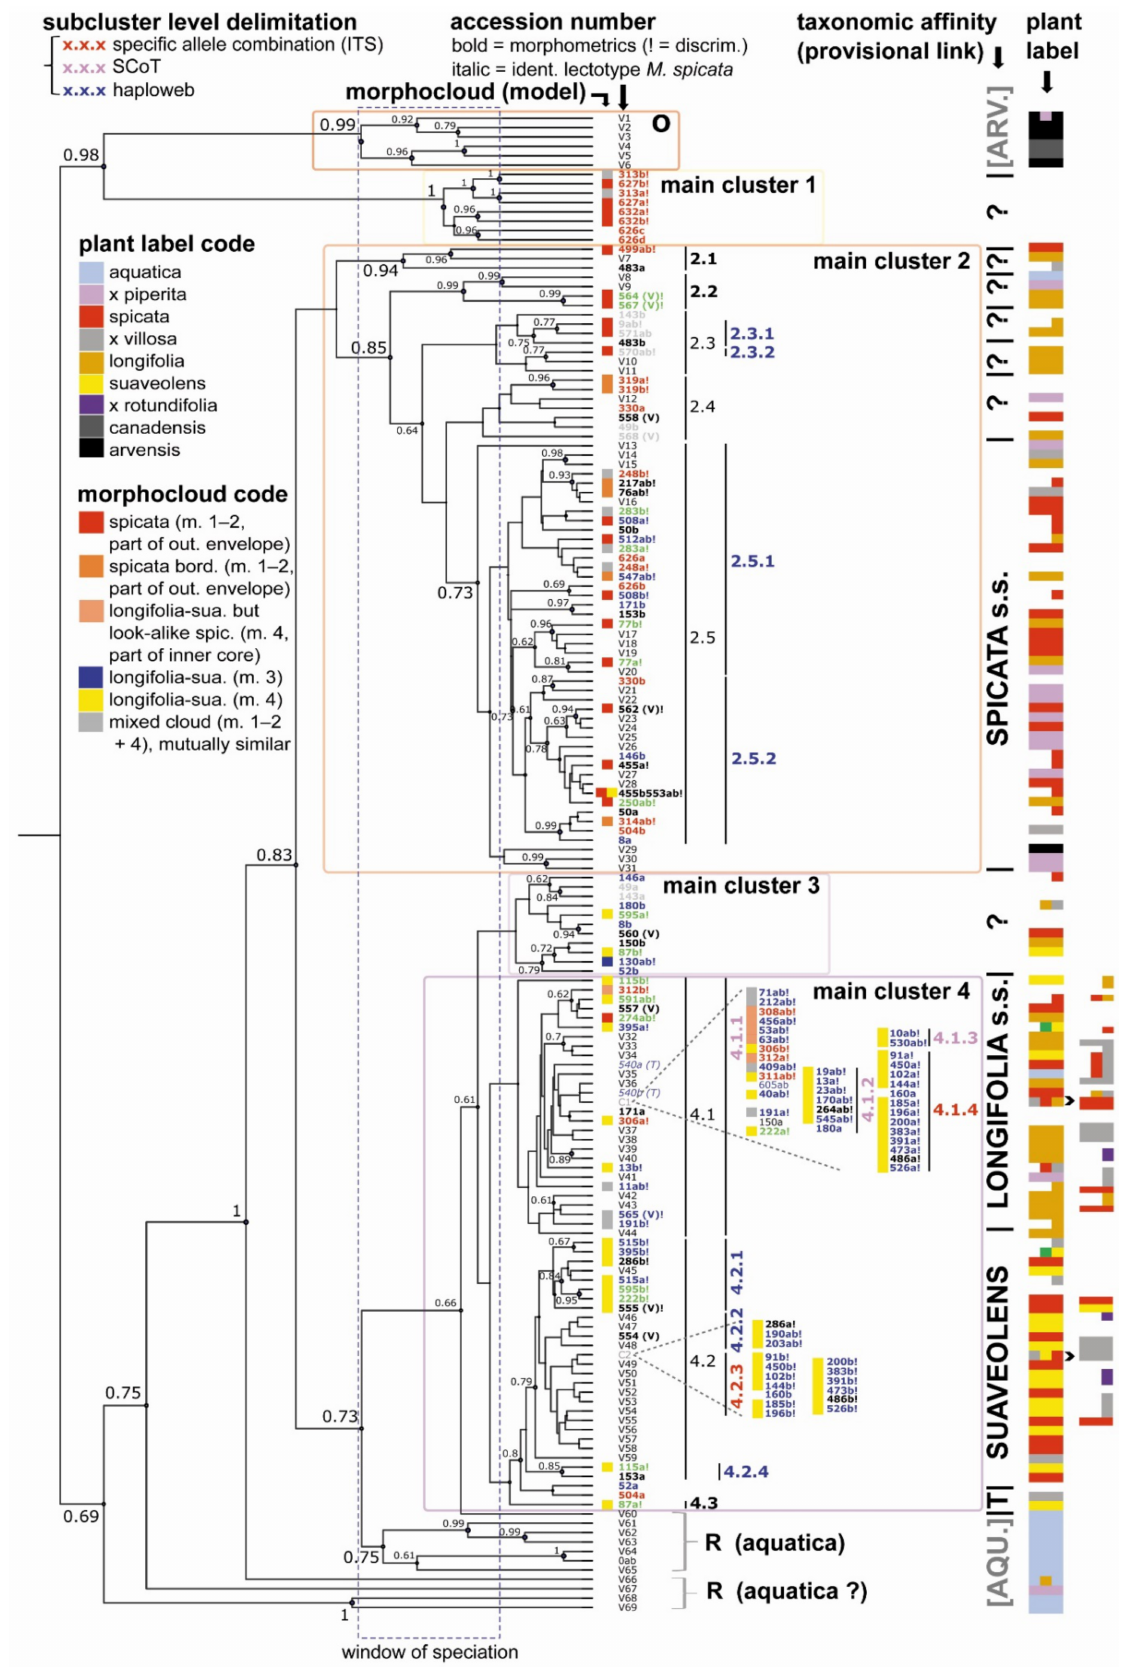
Figure 1. Ultrametric tree showing phylogenetic relationships within the genus Mentha subsect.